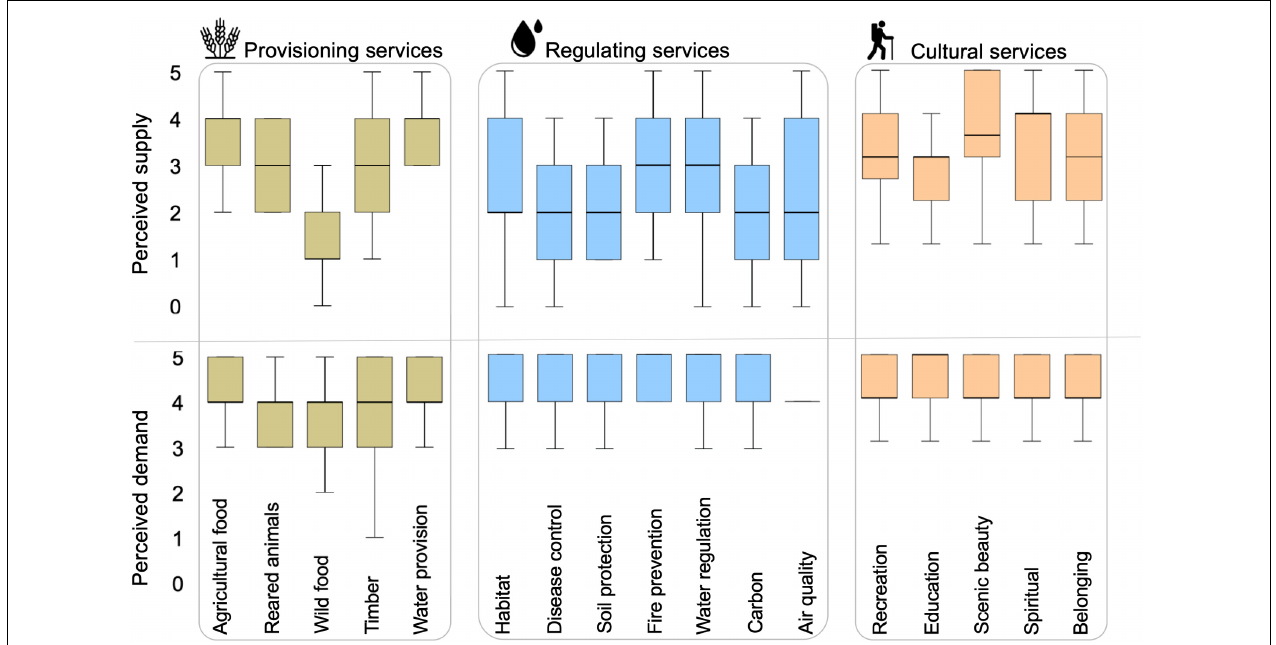
FIGURE 2 | Box plots with the scoring values for the supply (at the top) and demand (at the bottom) of ecosystem services ( n = 22), as ranked by the public officers during the questionnaire-based survey. Boxes depict the median and interquartile range (IQR: 1–3rd quartile), and whiskers represent the minimum and maximum score